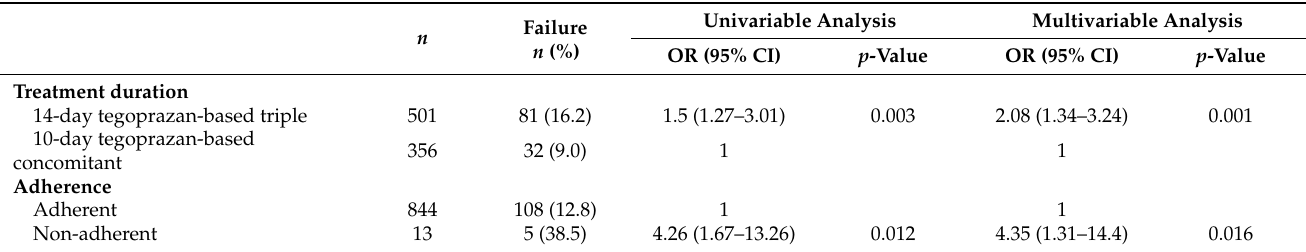
Table 4. Factors associated with failure of first-line H. pylori eradication a